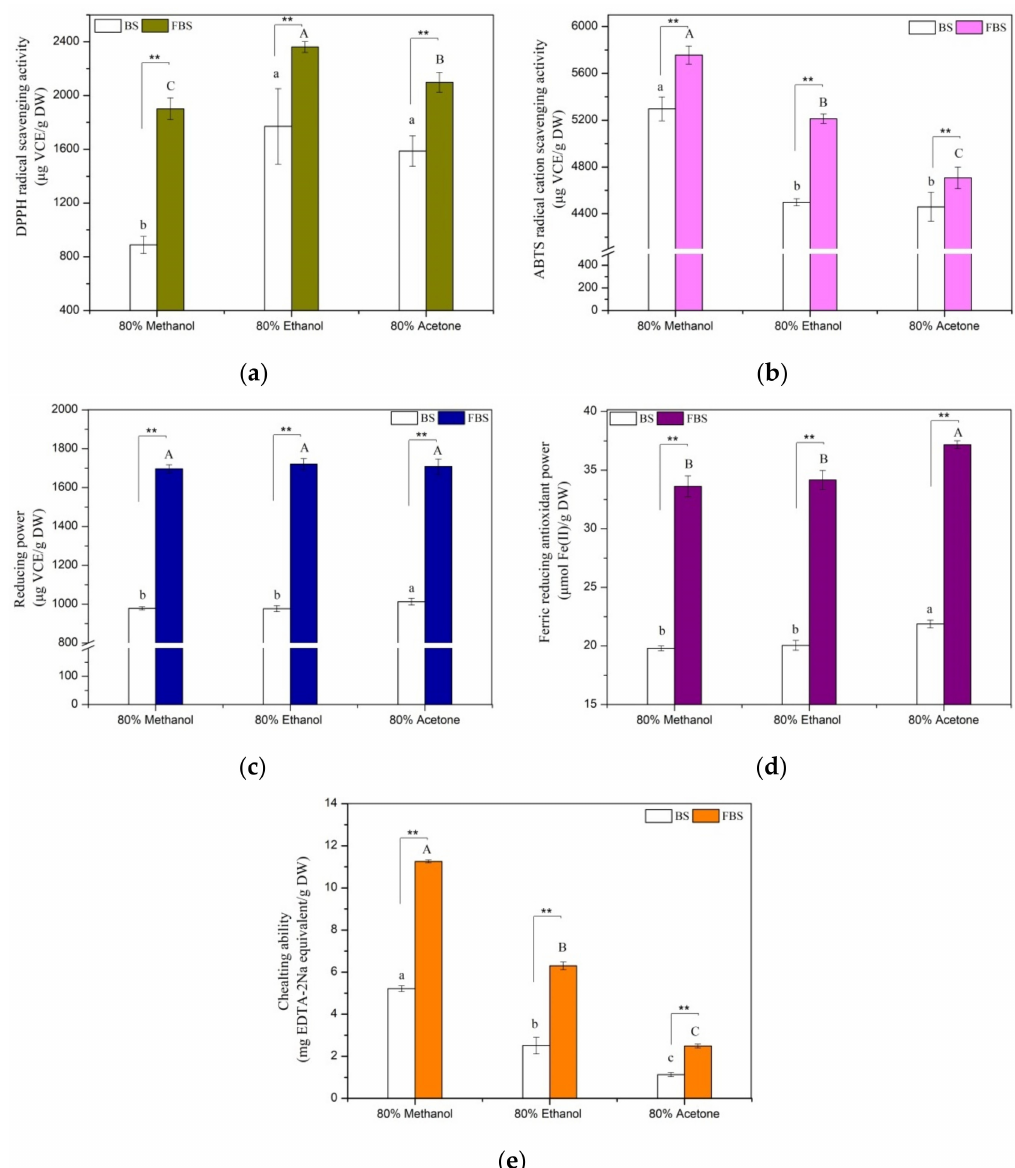
Figure 3. Antioxidant activities of the various extracts from non-fermented black soybeans (BS) and E. cristatum -fermented black soybeans (FBS). ( a ) Scavenging effect of DPPH radical, ( b ) ABTS · + scavenging effect, ( c ) ferric reducing antioxidant power (FRAP), ( d ) reducing power (RP), and ( e ) chelating ability. Values were represented as mean ± standard deviation of the triplicate assay. Values followed by different capital letters (A–C) or small letters (a–c) are remarkably different ( p < 0.05) among the different solvent extracts of FBS or BS, respectively. The symbols (**) denoted a significant difference at a level of 0.01 between FBS and BS regards the same extracted